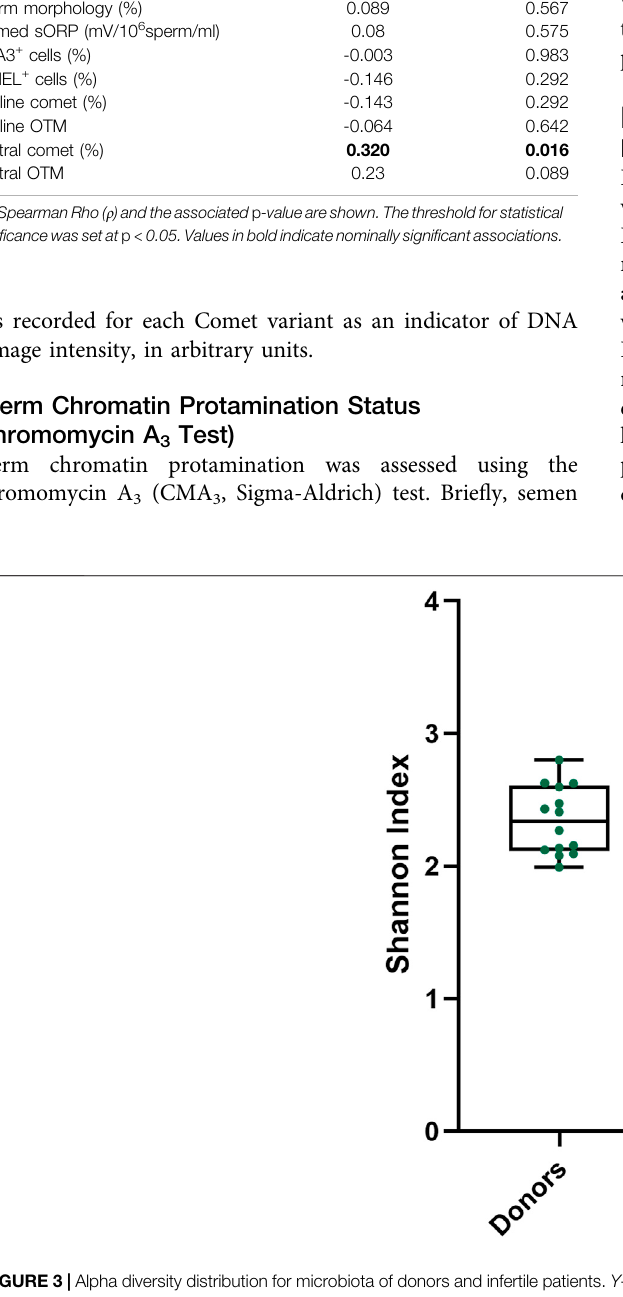
Frontiers in Cell and Developmental Biology |